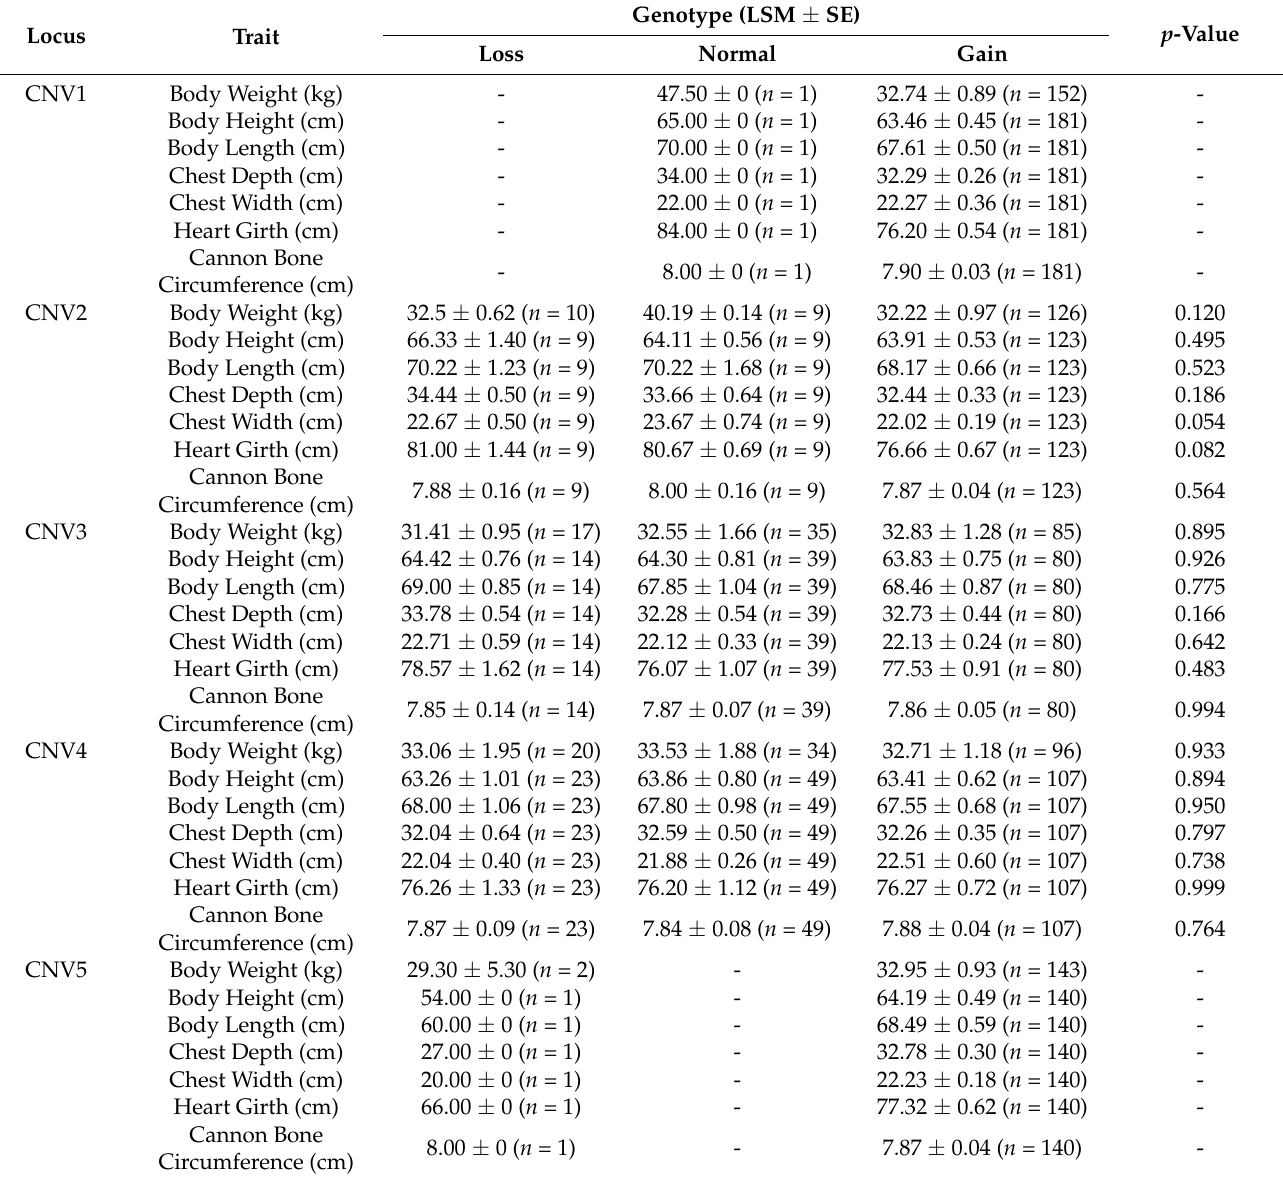
Table 4. Association analyses between morphometric traits and CNVs in Guizhou Heima